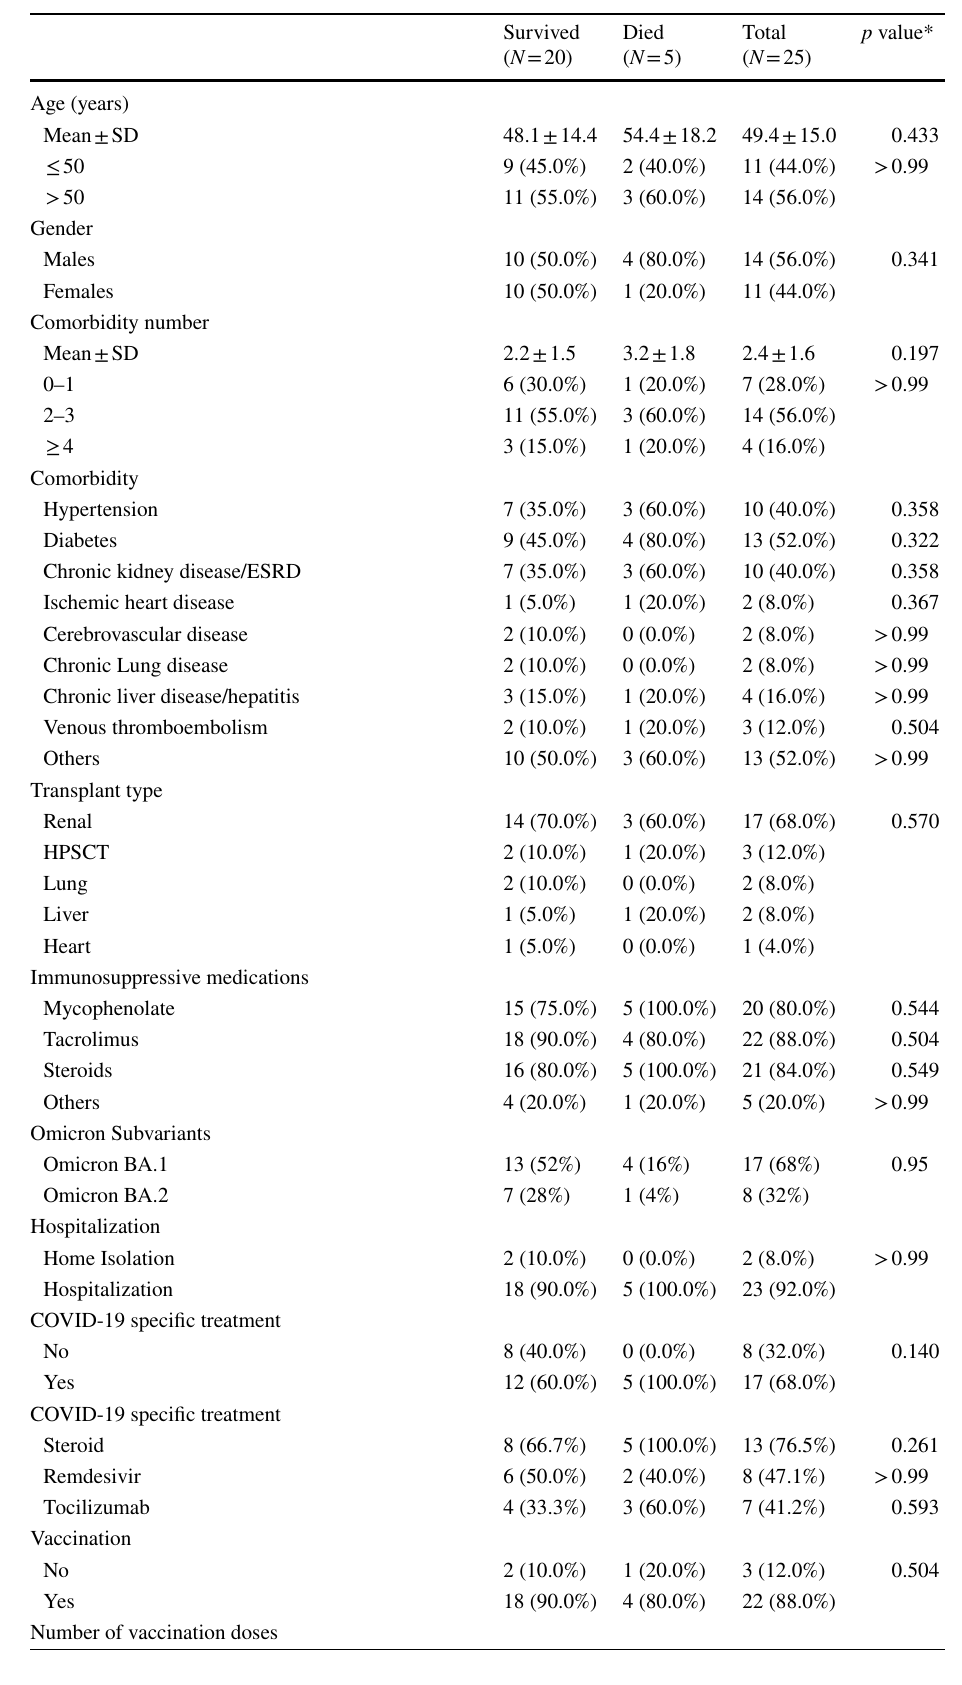
clinical characteristics of transplant patients with confirmed omicron variant of COVID-19 by death status